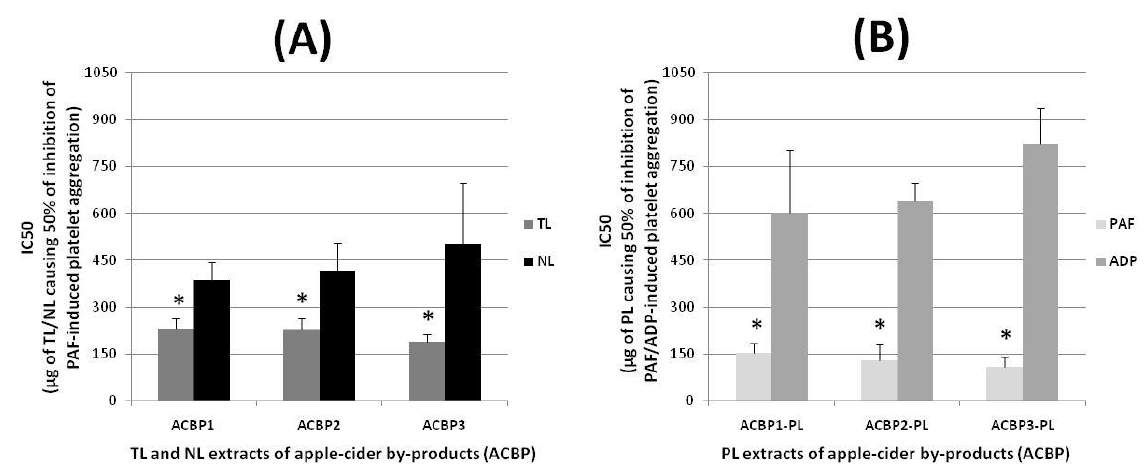
Figure 2. The anti-inflammatory and anti-platelet potency of TL ( A ), NL ( A ), and PL ( B ) extracts from ACBP, against human platelet aggregation induced by the inflammatory and thrombotic mediator PAF (for TL, NL, and PL) or by the platelet agonist ADP (for PL). Results are expressed as means of the IC 50 (half-maximal inhibitory concentrations) values in µg of TL, NL, and PL in the aggregometer cuvette that causes 50% inhibition of PAF/ADP-induced platelet aggregation (the lower the IC 50 value for a lipid extract the higher its inhibitory effect against the specific agonist of platelet aggregation). * denotes statistically significant difference ( p < 0.05) when the anti-PAF potency (IC 50 value) of the bioactive TL extracts were compared with the relative anti-PAF potency of the NL extracts for each ACBP ( A ), or when the anti-PAF potency (IC 50 value) of the bioactive PL extracts were compared with their relevant anti-ADP potency for each ACBP ( B ). Abbreviations: TL, total lipids; NL, neutral lipids; PL, polar lipids; ACBP, apple cider by-products (apple pomace); ACBP1, apple cider by-products of low in tannin Jonagold apple variety; ACBP2, apple cider by-products of medium in tannin Dabinett apple variety; ACBP3, apple cider by-products of high in tannin Aston Bitter apple variety; PAF, platelet-activating factor; ADP, adenosine 5′ diphosphate.